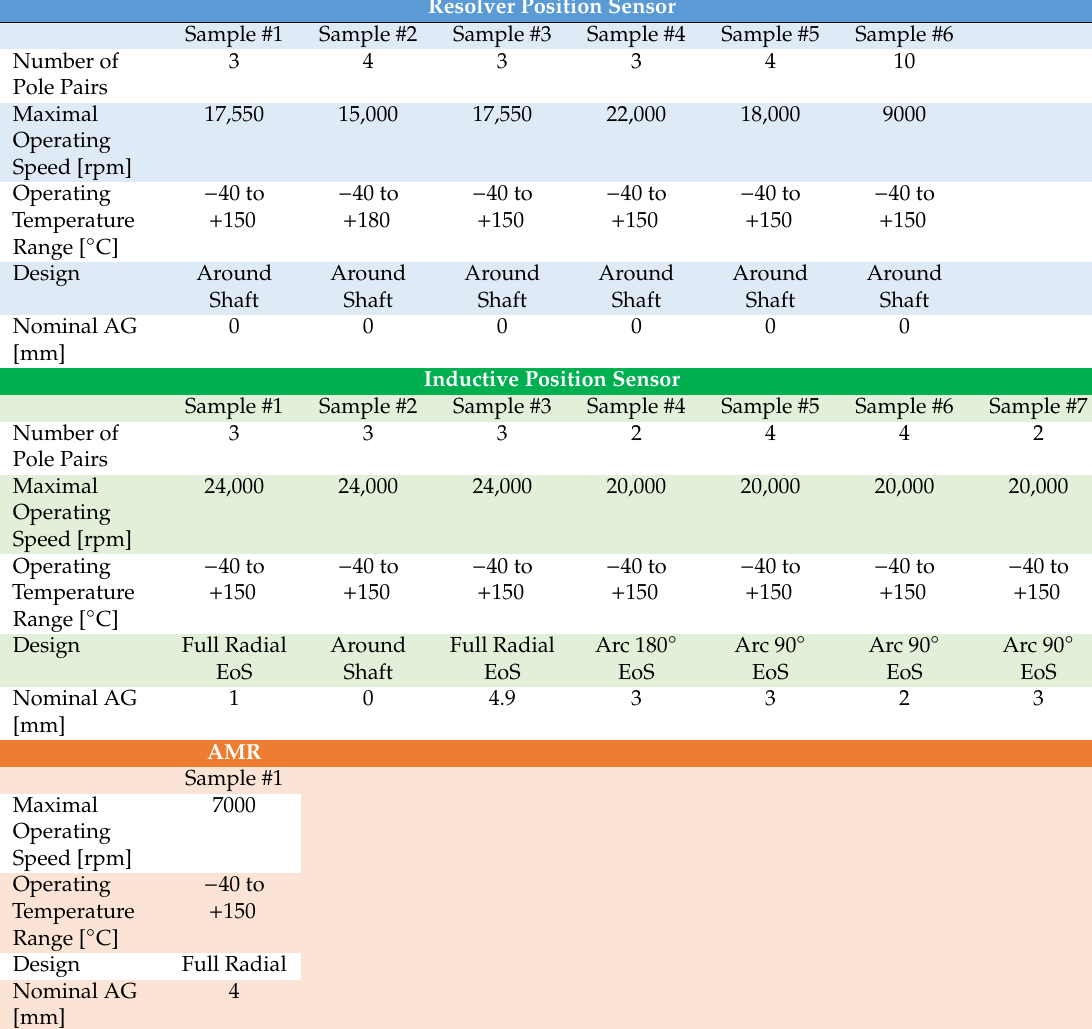
Table 5. Technical details of the tested